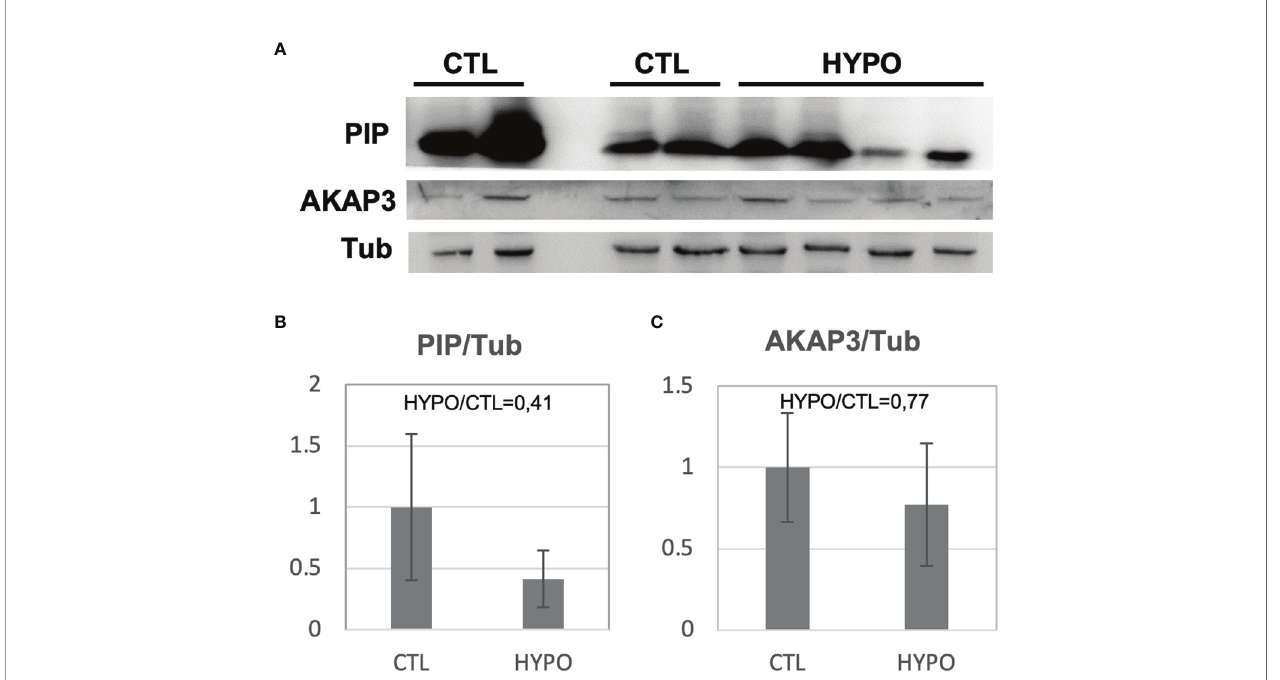
FIGURE 2 | Western Blot analysis for the PIP and AKAP3 proteins obtained from sperm samples of patients with secondary hypogonadism (HYPO) and controls (CTL) (A) . The histogram shows the ratio of densitometric values of PIP (B ) and AKAP3 (C) to Tubulin (Tub), a loading control. The ratio from control (CTL) was arbitrarily set to 1. Mean ± SD of patients is